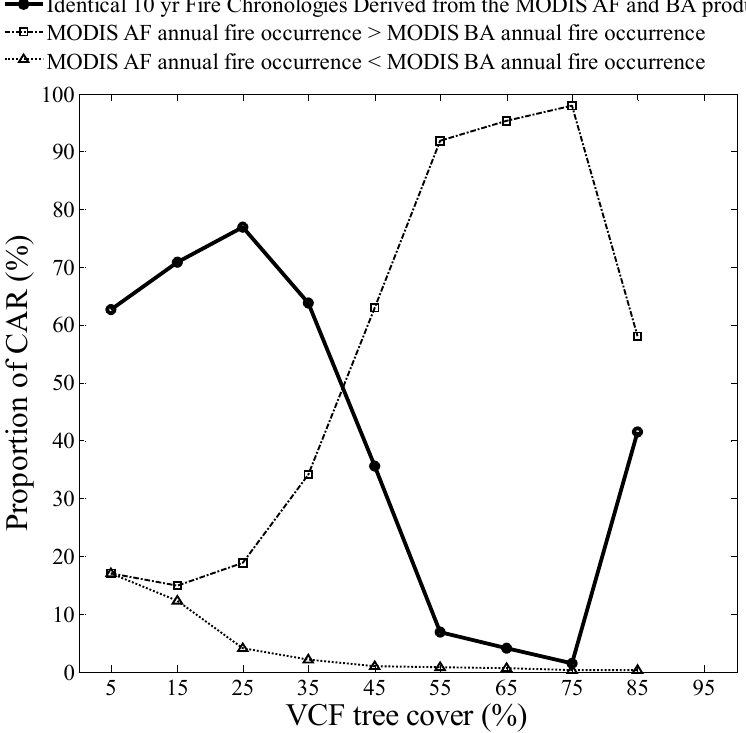
Figure 9. Comparisons of fire chronologies at 0.05° grid cell resolution derived from ten years of the MODIS active fire (MCD14ML) and MODIS burned area (MCD45A1) datasets, expressed as a function of median tree canopy cover characterized using the Vegetation Continuous Field (VCF) product